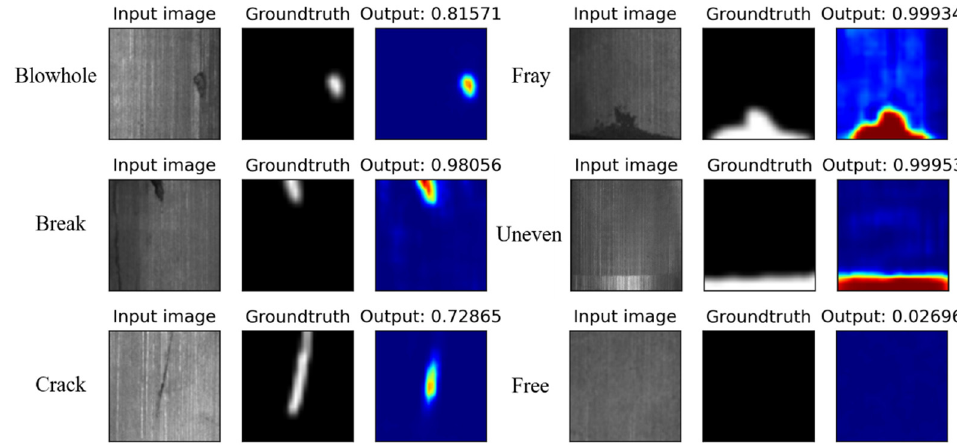
Figure 14. The output result images of the method mentioned on the MT dataset.